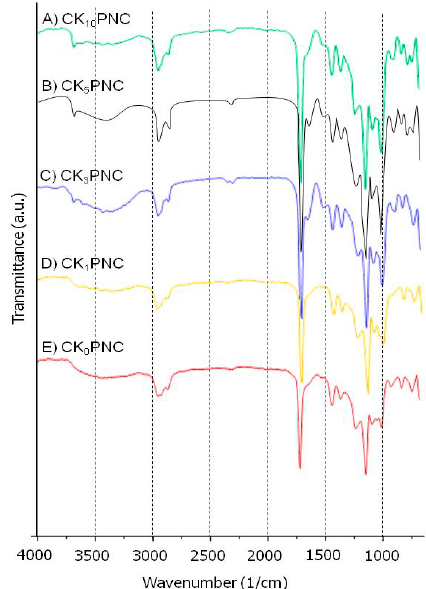
Figure 1. Attenuated total reflection infra-red (ATR-IR) spectra of films produced from nanocomposite of poly(methylmethacrylate) (PMMA) and choline chloride modified kaolinite (CCMK). ( A ) CK 10 PNC, ( B ) CK 5 PNC, ( C ) CK 3 PNC, ( D ) CK 1 PNC and neat PMMA ( E ) CK 0 PNC.